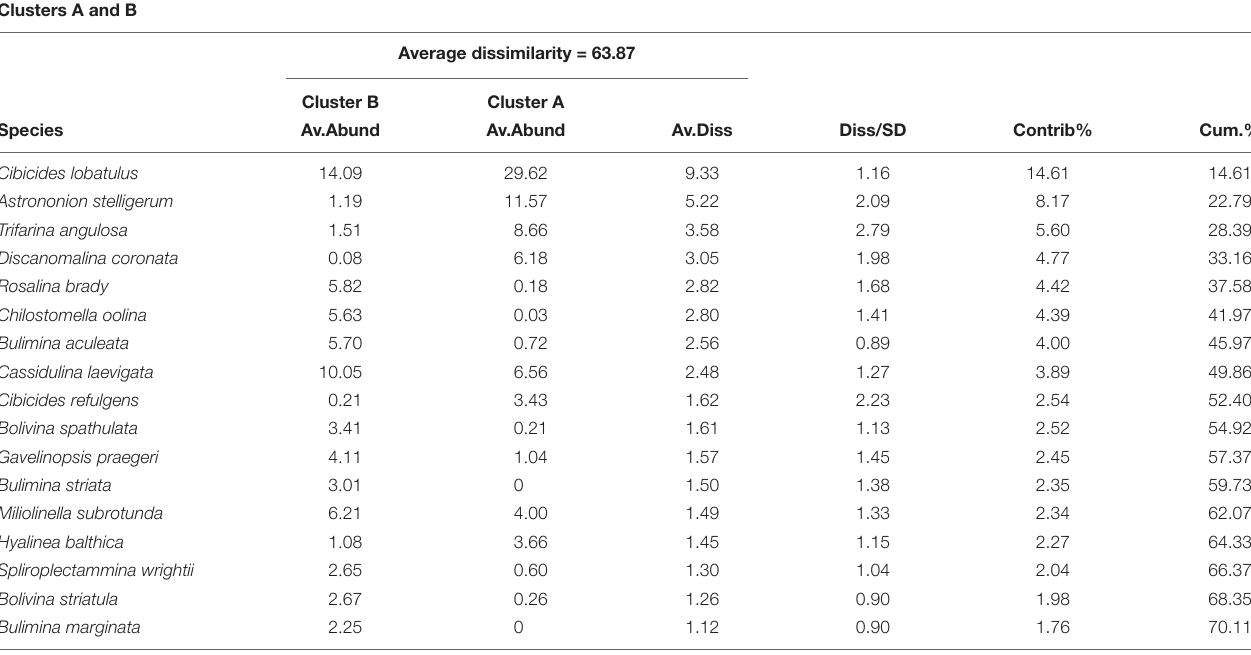
TABLE 4 | List of the species contributing to the dissimilarity between clusters A and B, which separate at 47% similarity on the hierarchical cluster analysis ( Figure 5 ). Clusters A and B Average dissimilarity = 63.87 Cluster B Cluster